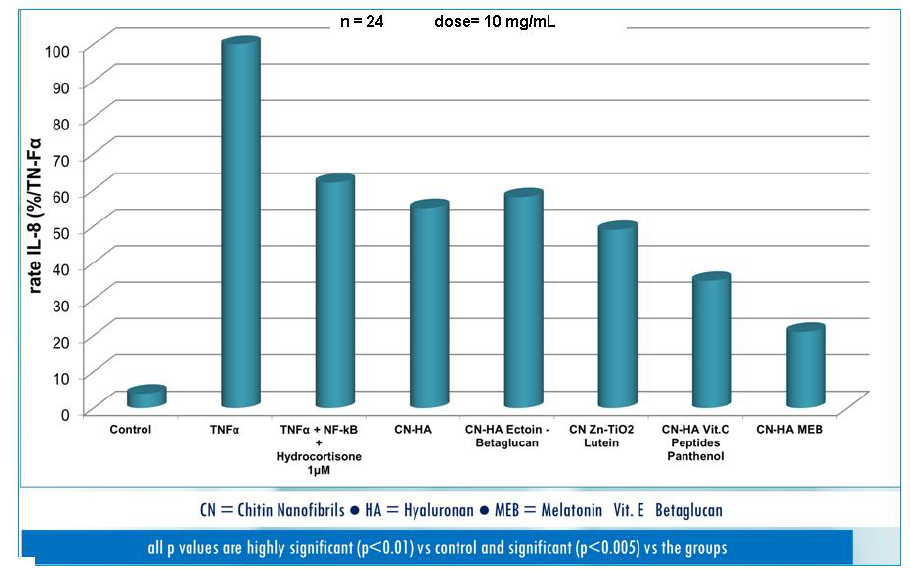
Figure 16. Inhibition of IL-8release on TNF- α (Tumour Necrosis Factor- α ) stimulated human keratinocytes. All p values are highly significant ( p < 0.01) vs. control and significant ( p < 0.005) vs. the